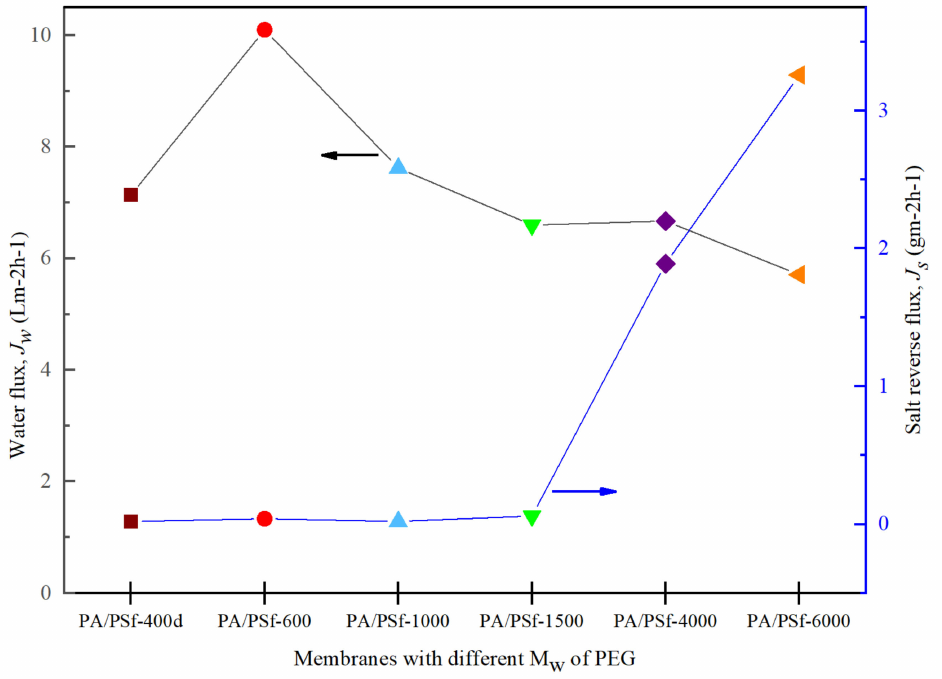
Figure 13. The water flux, J w , and salt-reverse flux, J s , in the PRO experiment for modified TFC membranes with different M w s of